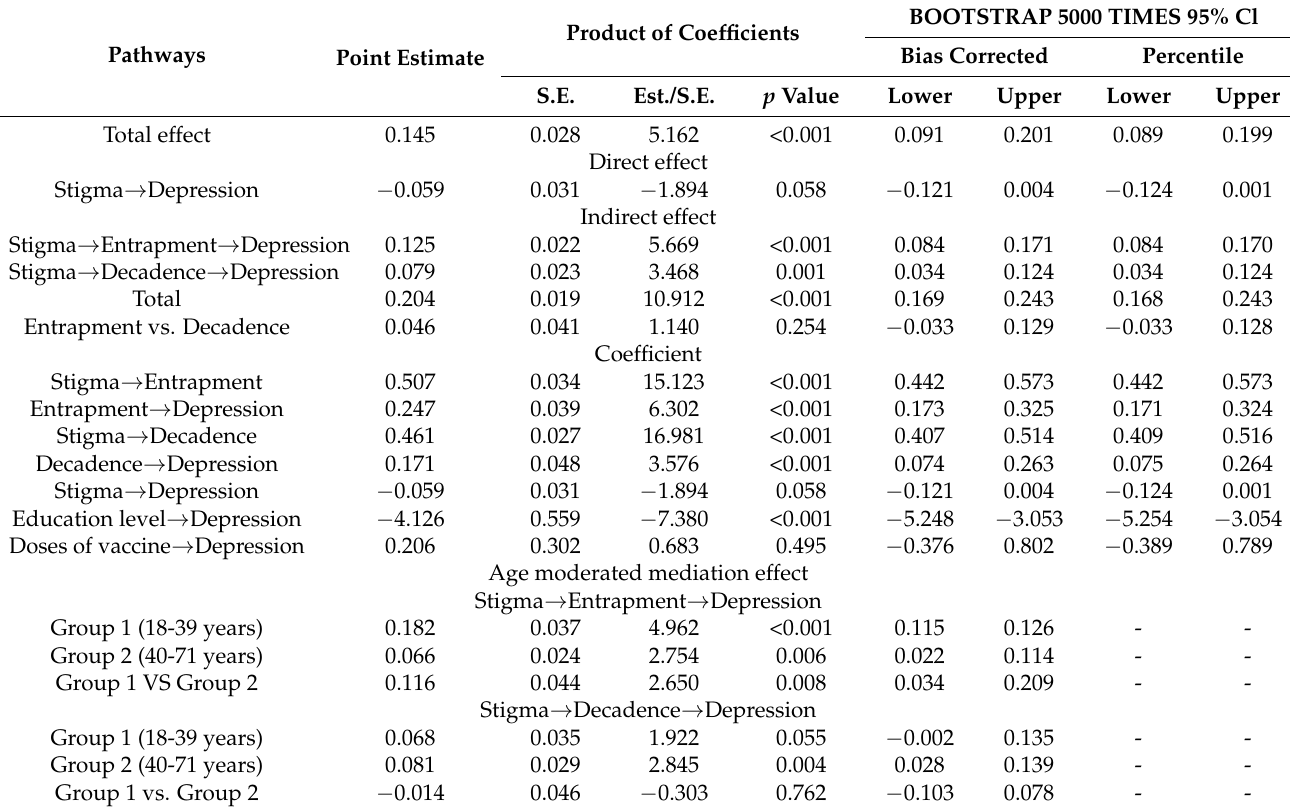
Table 4. Results of path analysis ( n = 1283).